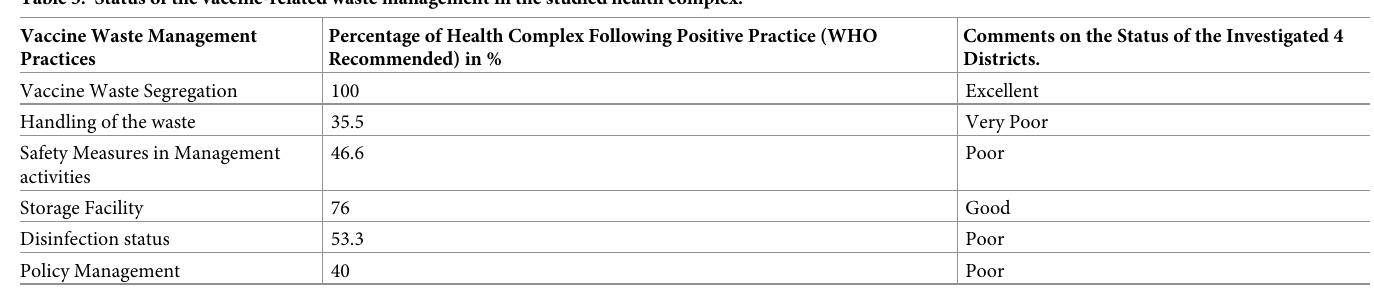
Table 3. Status of the vaccine-related waste management in the studied health complex. Vaccine Waste Management Practices